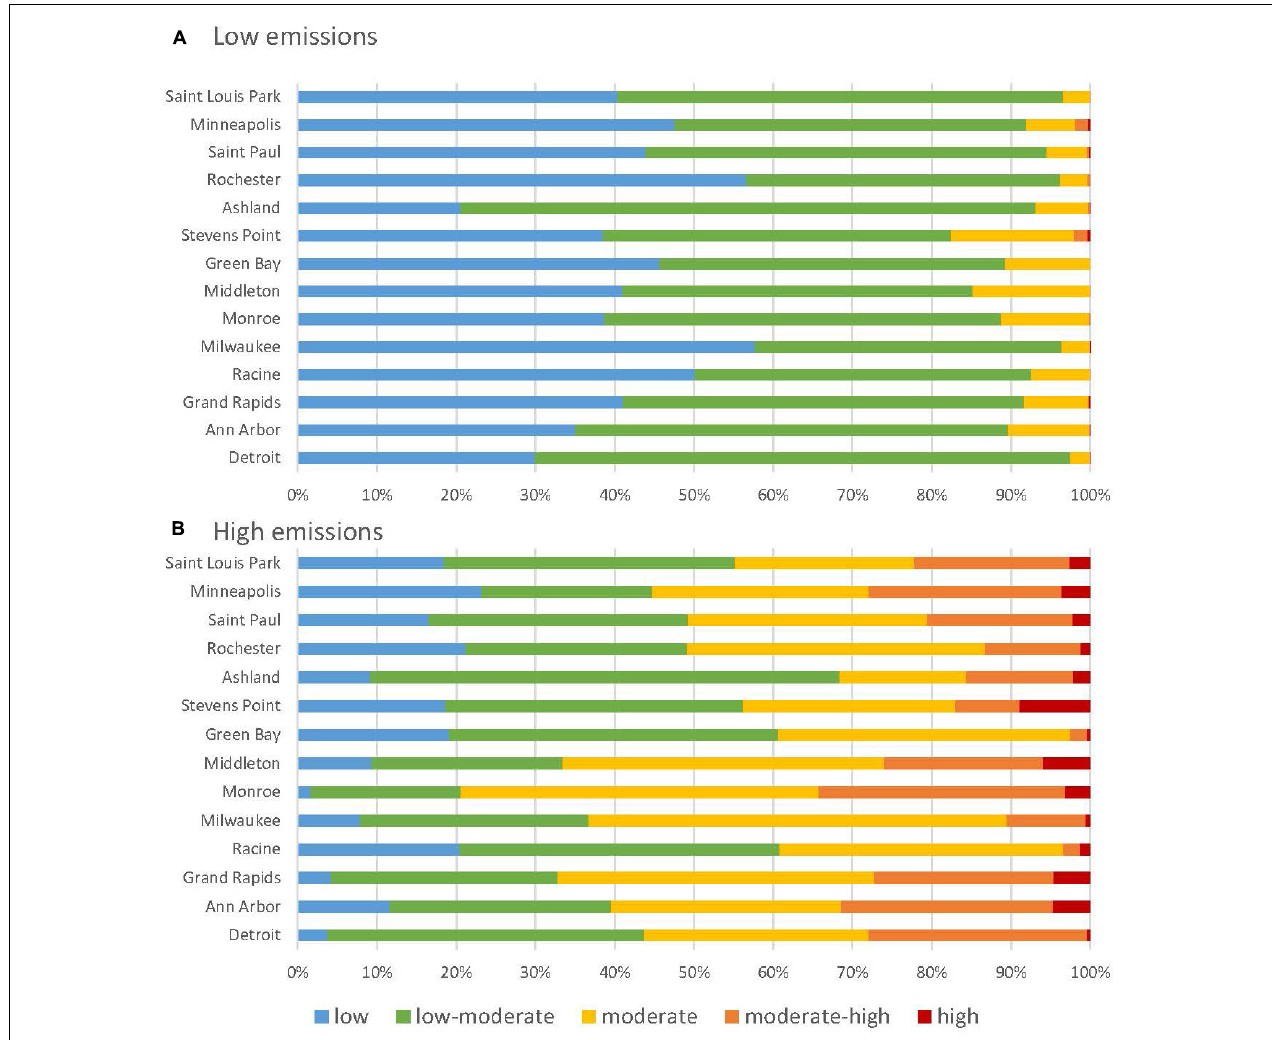
FIGURE 5 | Percent of street trees in each vulnerability category by municipality under an (A) low emissions pathway (RCP 4.5) or (B) high emissions pathway (RCP 8.5). Municipalities are arranged bottom to top from southeast to northwest.